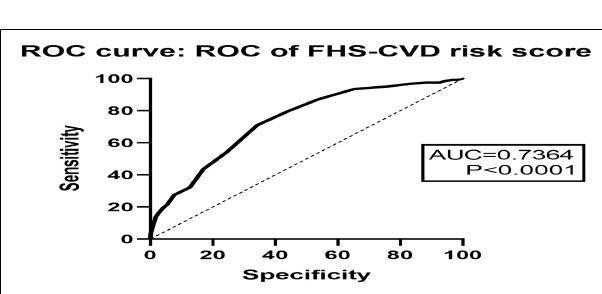
FIGURE 5 | The ROC curve showed that FHS–CVD risk score had effective diagnostic significance in predicting POD